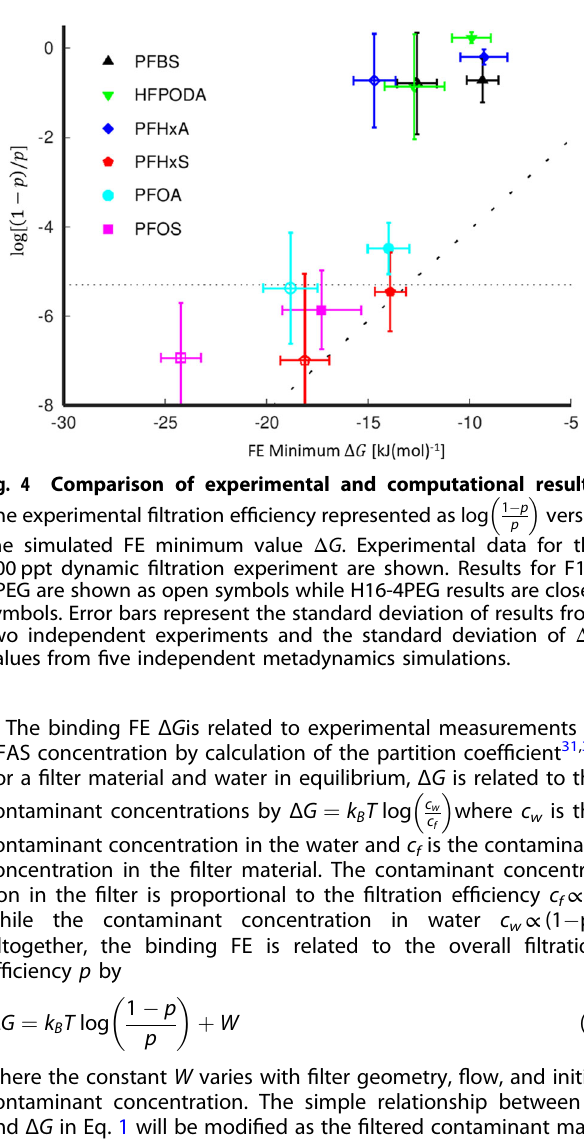
data for 100 ppt contaminant sample water with simulated interaction FE values. The experimental data are recorded as